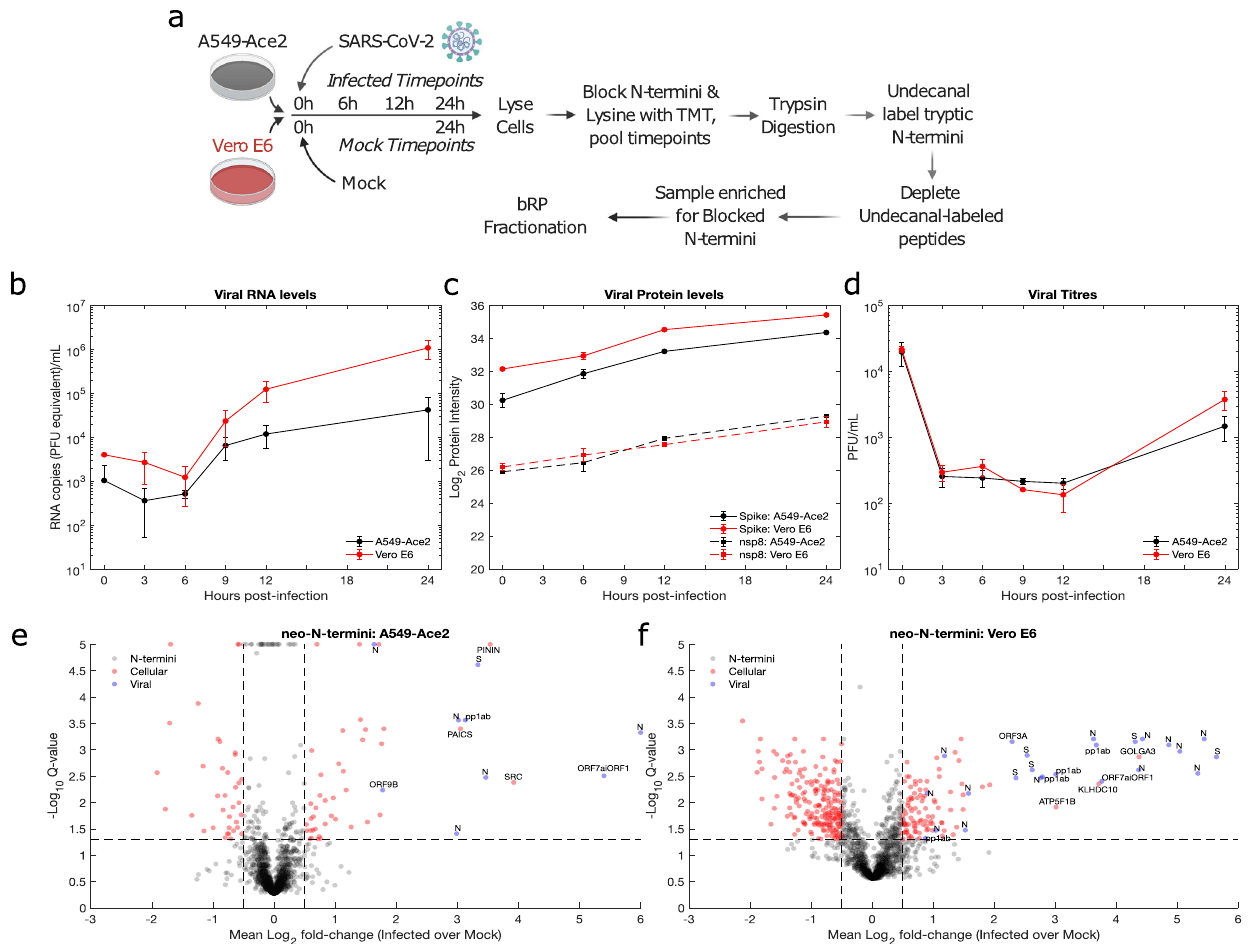
Fig. 1 N-terminomic analysis of SARS-CoV-2 infection of A549-Ace2 and Vero E6 cells. a Experimental design. b Viral RNA levels were determined by qRT-PCR ( n = 3 biological replicates). c Protein levels were determined based on the TMTpro fractional intensity of the total protein intensity for the unenriched proteomic samples ( n = 3 biological replicates). d Infectious virus production (PFU, n = 3 biological replicates). Error bars for b – d represent standard deviation. e A549-Ace2 and f Vero E6 neo-N-terminomic analysis reveals signi fi cant increases in peptides corresponding to viral and cellular neo- N-termini, where neo-N-termini must begin from amino acid 2 or later. P values were obtained by two-tailed unpaired t -test, correction for multiple- hypothesis testing to obtain Q-values was performed as described Storey (2002) 70 . bRP basic reverse phase fractionation, PFU plaque-forming units. The vertical and horizontal lines correspond to fold change (0.5) cut-off and Q-value (0.05) cut-offs,